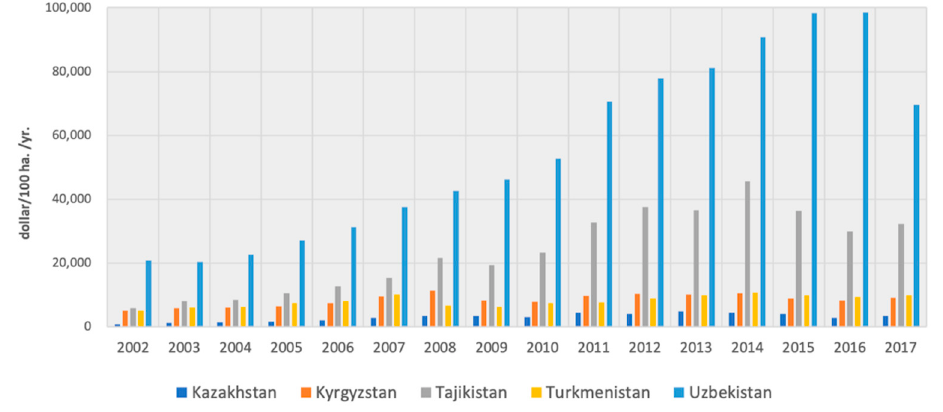
Figure 4. Change of land productivity in Central Asia.